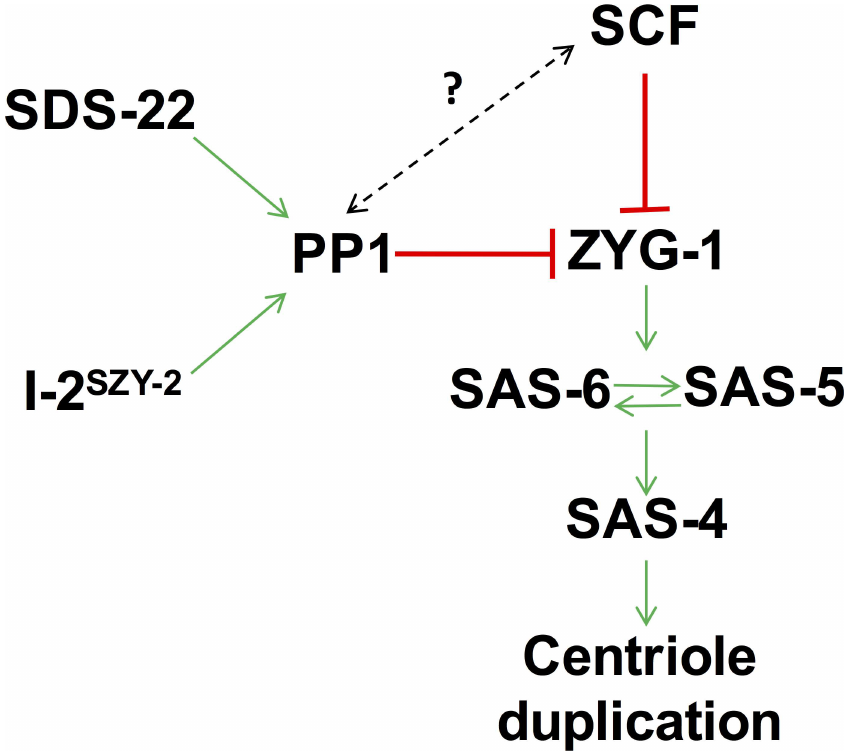
Fig 6. Model of how I-2 SZY-2 , SDS-22 and PP1 might cooperate with the SCF to regulate centriole duplication. Our work shows that PP1, I-2 SZY-2 and SDS-22 down regulateZYG-1 levels to constrain centriole duplication.We speculatethat this is a new mechanism of regulationthat operates independently of the previously documented SCF-mediated regulation.We cannot rule out, however,an interplaybetweenthe two pathways(dotted